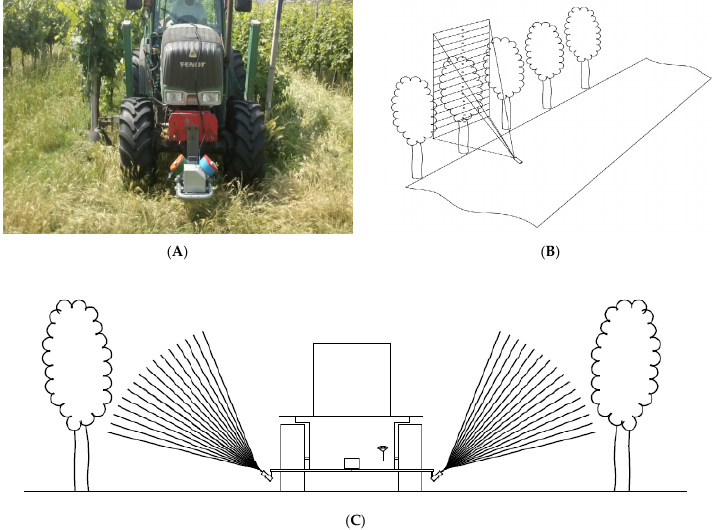
Figure 1. ( A ) MECS ‐ VINE ® sensor mounted in front of a tractor; ( B ) MECS ‐ VINE ® operation scheme: sensor ʹ s field of view (FOV) and ( C ) MECS ‐ VINE ® operation scheme (plan ‐ view) and canopy wall breakdown into sectors.